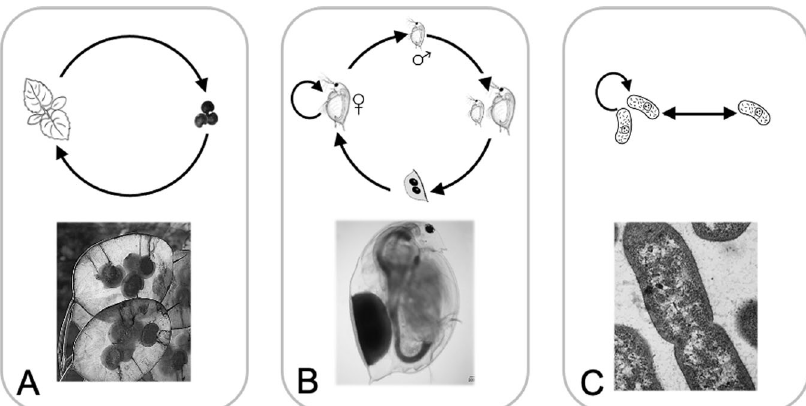
Fig. 1 Seed banks develop among diverse taxa with different life histories and reproductive modes. A Annual plants, like Lunaria , produce seeds at the end of a growing season, which are deposited into the soil. A well-recognized example of bet-hedging, some fraction of these seeds will delay germination despite optimal conditions. B Daphnia is a planktonic crustacean with parthenogenic reproduction, where females generate offspring without fertilization. When stressed, some species produce males, who in turn fertilize females, leading to the production of dormant resting stages (ephippia) that can persist for extended periods of time in aquatic sediments. C Among many groups of microorganisms, including gut bacteria like Bacteroides , individuals can enter and exit from a dormant state independent of reproduction and without the need of generating physical resting structures. Part ( A ) image is courtesy of P. Meyer. Part ( B ) image is courtesy of J. Haney and the illustration is courtesy of J. Ferguson (https://www.paintingbiology.com). Part ( C ) image is courtesy of C. Skilbeck, (www.cronodon.com).